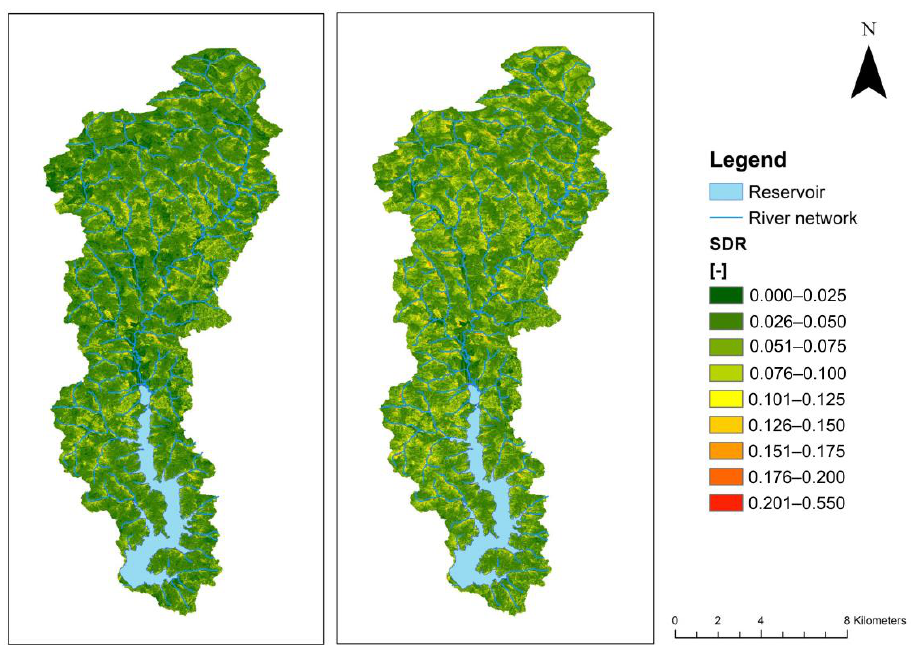
Figure 15. Sediment delivery ratio (SDR) for the months of July 2017 ( right ) and January 2018 ( left ).